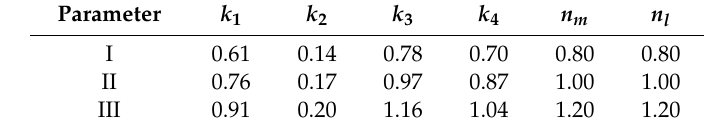
Table 6. Values of specific heat parameters.